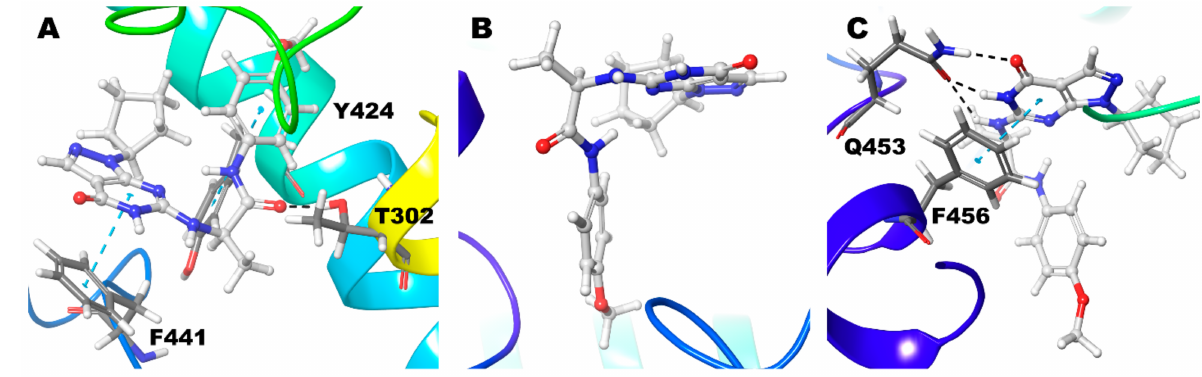
Figure 7. Non-bonded interactions of Compound 3 ( R ) in ( A ) PDE9 Zn/Mg ( B ) PDE9 Mg/Mg ( C ) PDE9 Zn/Zn.